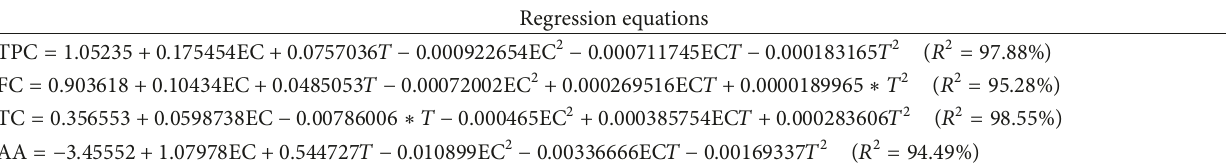
Table 2: Second order polynomial equations relating response variables to test variables for apricot pomace. 𝑇 is the temperature and EC is the ethanol concentration. 𝑅 2 , the coefficients of regression, are shown for each equation. Regression equations